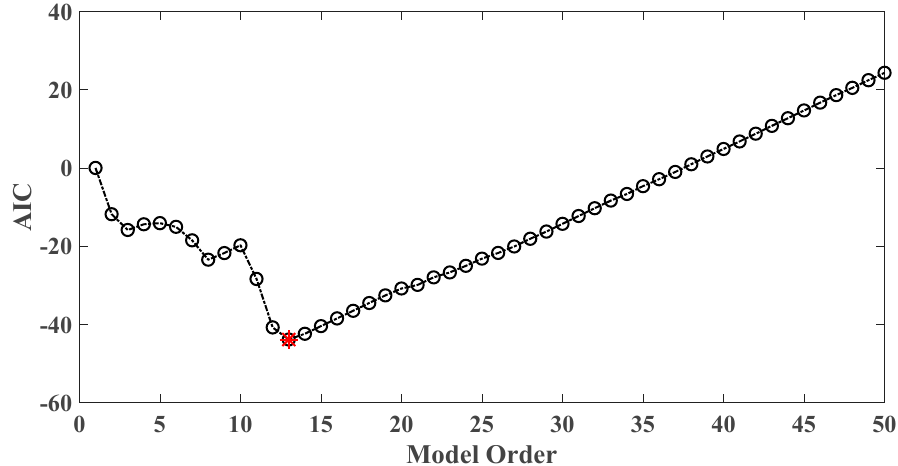
Figure 12. AIC of an AR model for the third floor response under the case of 30% damage occurring on the third floor (mutually correlated white noises inputs, 5% noise).